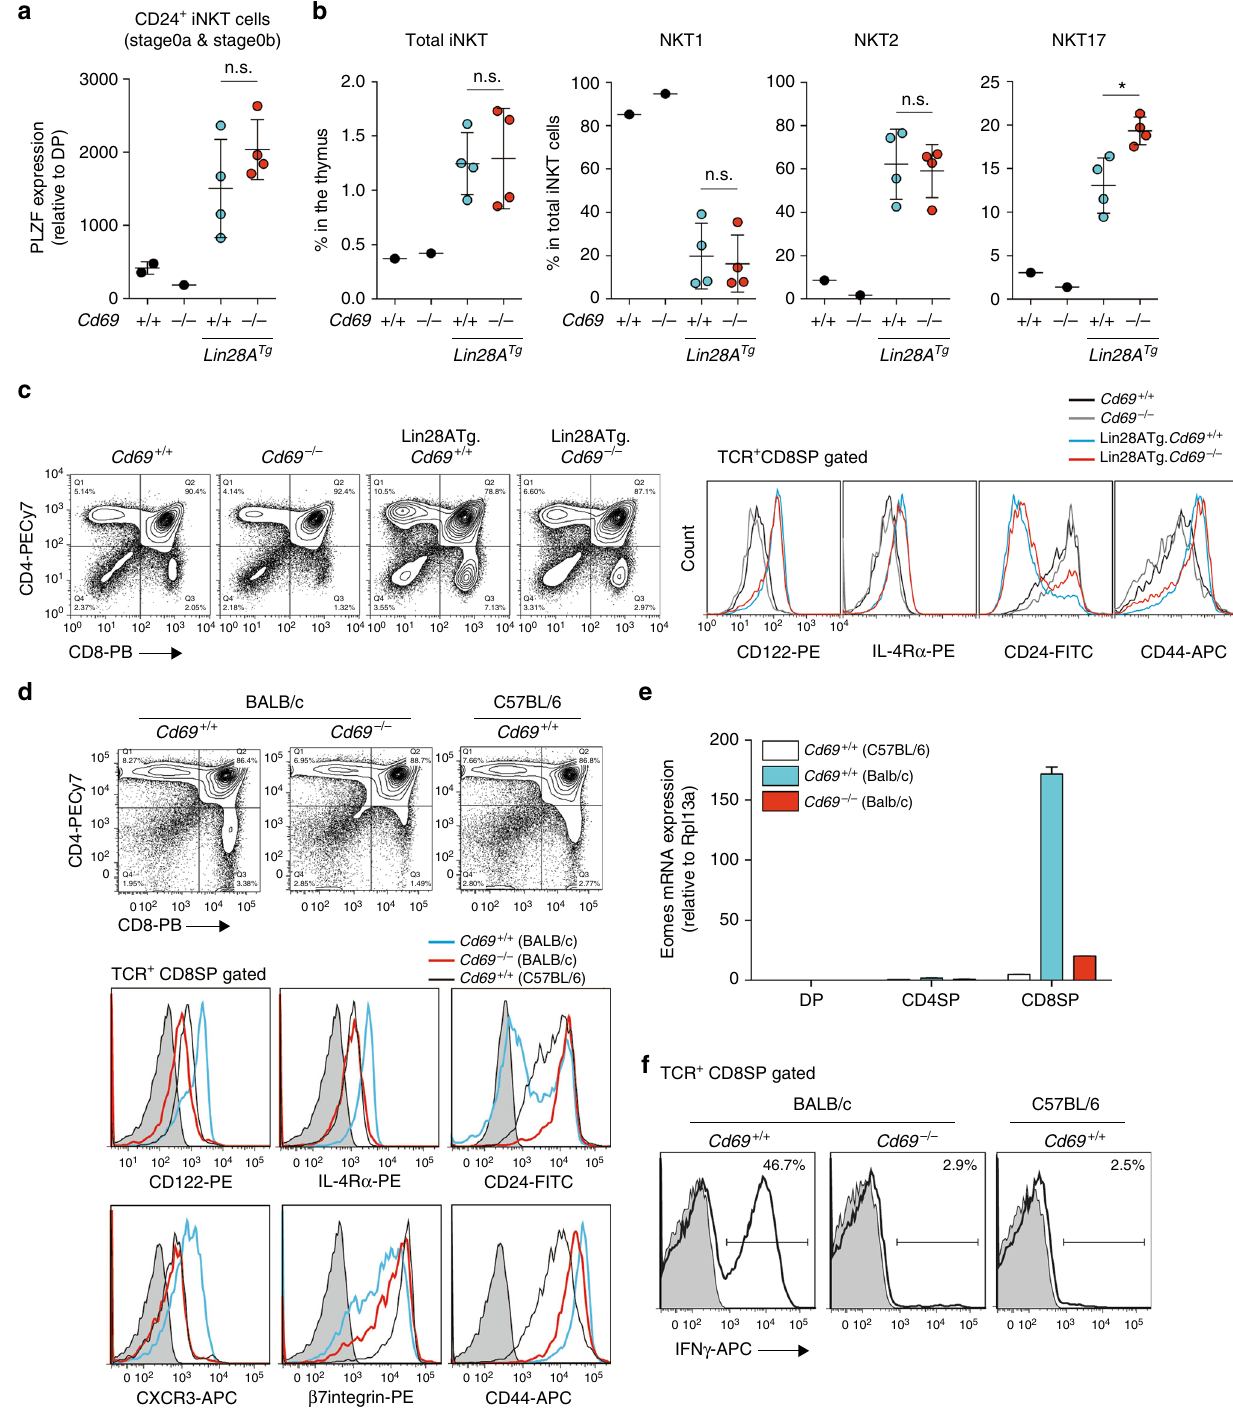
Fig. 6 Impact of let-7 miRNA on PLZF expression in stage 0b precursors. a The PLZF expression in CD24 + NKT precursors (stage 0) of the indicated mice, presented relative to that in preselection thymocytes. b The frequencies of iNKT cells in the thymus and the frequencies of NKT1 (PLZF lo T-bet + ), NKT2 (PLZF hi Ror γ t med ), and NKT17 (PLZF med Ror γ t hi ) cells among total iNKT cells of the indicated mice. c The CD4/CD8 pro fi les of the thymus from the indicated mice. The expression of CD122, IL-4R α , CD24, and CD44 gated on TCR β + CD8SP cells of the indicated mice are shown. d The CD4/CD8 pro fi les of the thymus from Cd69 + / + and Cd69 – / – BALB/c-background mice and Cd69 + / + C57BL/6-background mice. The expression of CD122, IL-4R α , CD24, CXCR3, β 7integrin, and CD44 gated on TCR β + CD8SP cells from the indicated mice are shown. e The Eomes mRNA expression relative to Rpl13a in sorted preselection TCR β lo-med DP cells, TCR β + CD4SP and TCR β + CD8SP cells from the indicated mice is shown. f Intracellular staining of IFN γ in TCR β + CD8SP thymocytes from the indicated mice after PMA + ionomycin stimulation for 4 h. The mean and SEM are shown. * p < 0.05 (two-tailed unpaired t test). Data are pooled from two experiments with four mice (Lin28A Tg) ( a , b ). Representative data from two experiments with more than four mice (Lin28A Tg) are shown ( c ). Representative data from more than fi ve experiments with more than ten mice ( d ) and two experiments with three mice ( e , f ) are shown. n.s. not signi fi